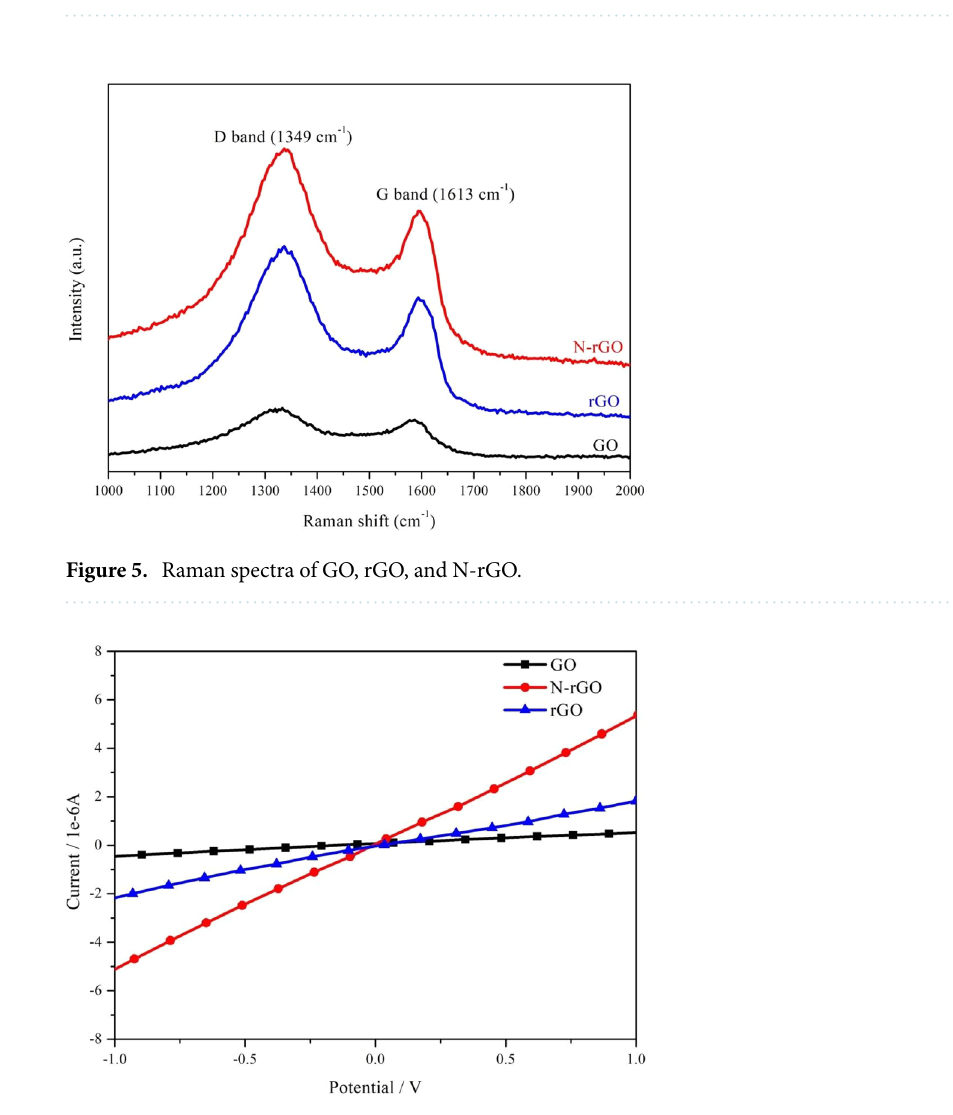
Figure 4. UV–vis absorption spectra of GO, rGO, and N-rGO.